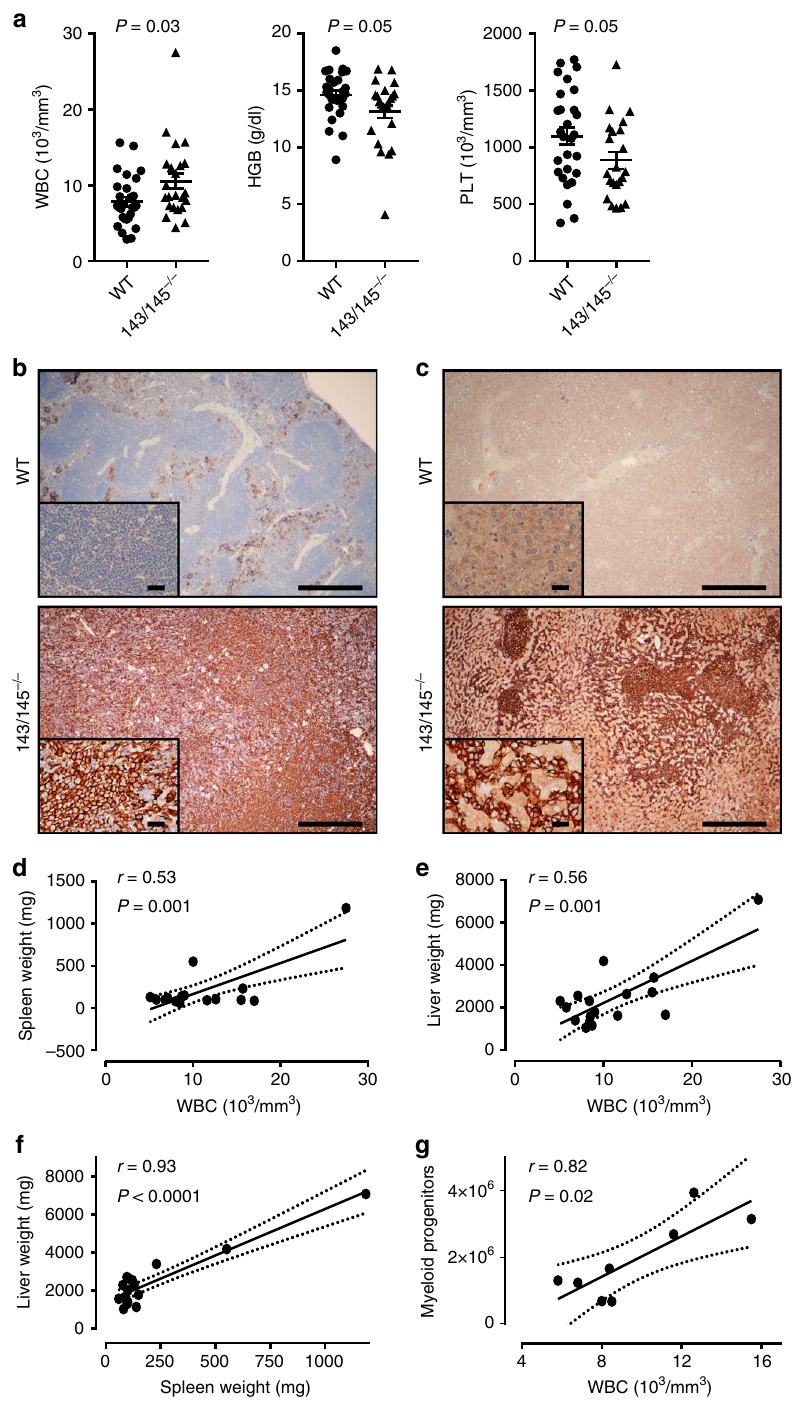
Fig. 7 Long-term miR-143-145 de fi ciency results in myeloid expansion. a White blood cell (WBC), hemoglobin (HGB), and platelet (PLT) counts in peripheral blood of 80-week-old wild-type (WT; n = 28) and miR-143/145 − / − mice ( n = 23). b Micrographs of spleen sections from WT and miR-143/145 − / − mice immunostained for Mac1 (CD11b) (scale bar: 50 μ m). Insets show higher magni fi cation of selected area (scale bar: 100 μ m). c Microscopic images of liver sections from WT and miR-143/145 − / − mice immunostained for CD11b (scale bar: 50 μ m). Insets show higher magni fi cation of selected area (scale bar: 100 μ m). d – g Linear regression and Pearson's correlation analysis was performed on data from aged miR-143/145 − / − mice (82 – 101 weeks old) to compare the relationship between spleen/liver weights and WBC count ( d , e , n = 17), spleen and liver weight ( f , n = 17), and WBC count and the number of progenitors (Lin − Sca1 − c-Kit + ) ( g , n =